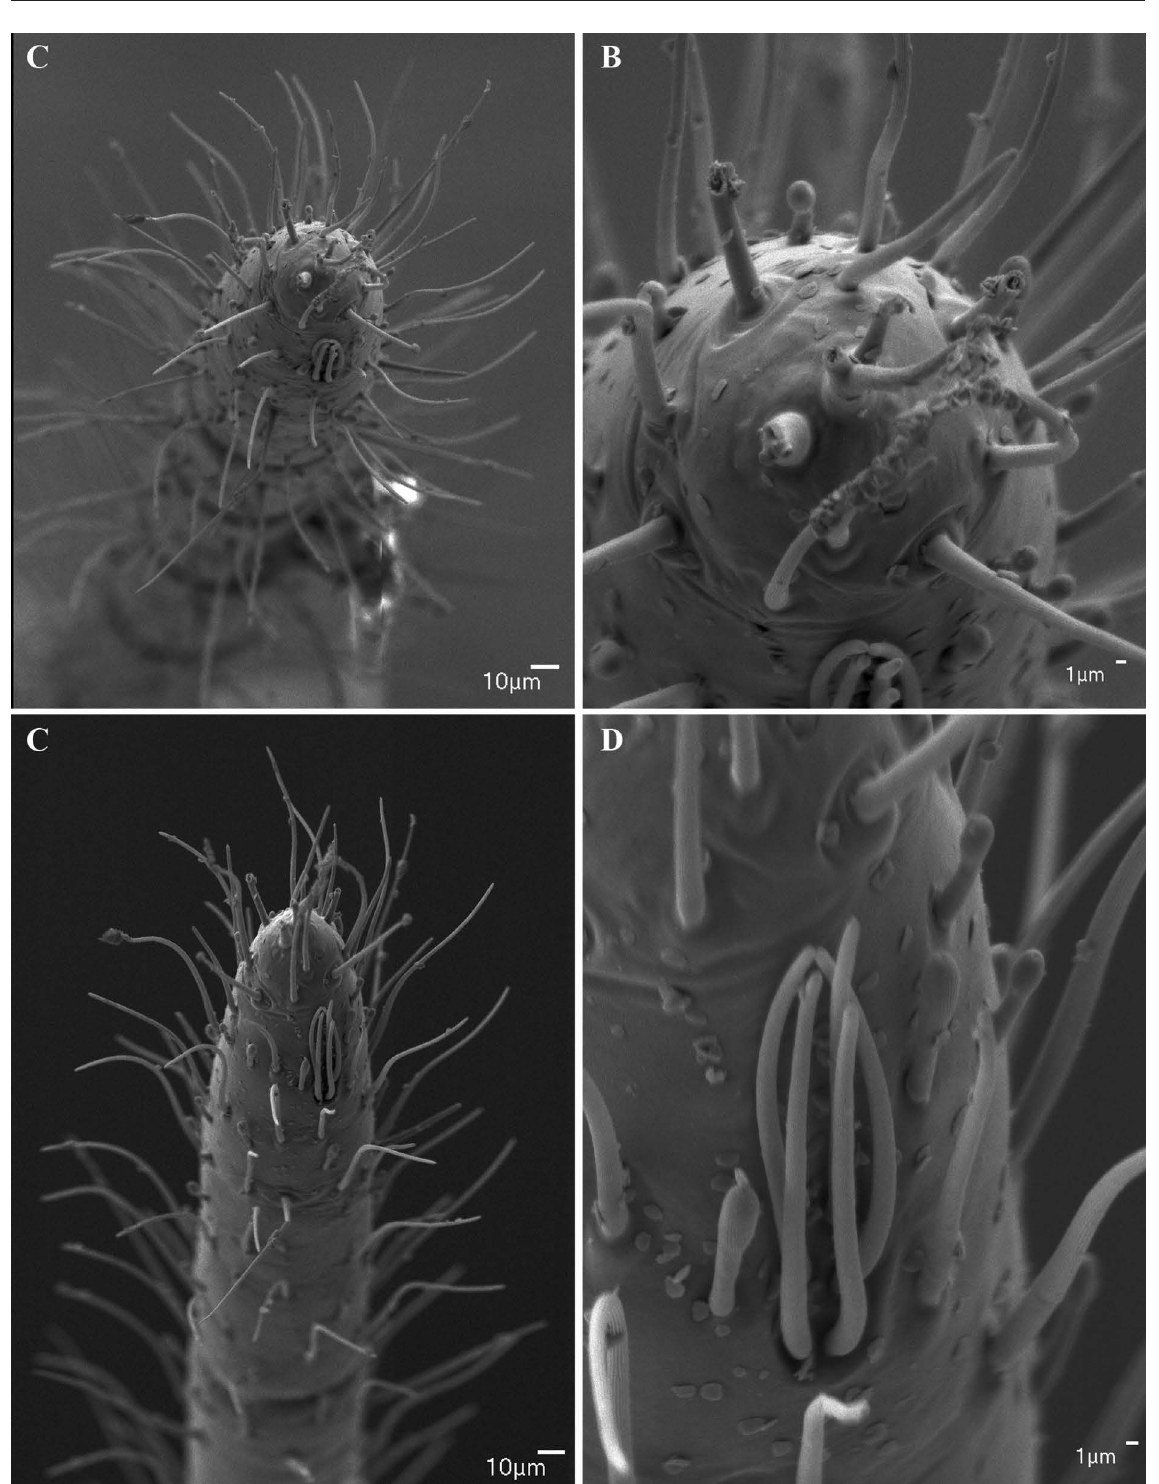
Fig. 147. Sarax seychellarum (Kraepelin, 1898) comb. nov. (AMCC [LP 9075]), antenniform leg I, ♂. A . Apex of distal article of tarsus showing modified claw, rod sensilla and tarsal organ. B . Close-up of claw and tarsal organ. C . Apex of tarsus showing rod sensilla and olfactory setae, lateral view. D . Rod sensilla and olfactory